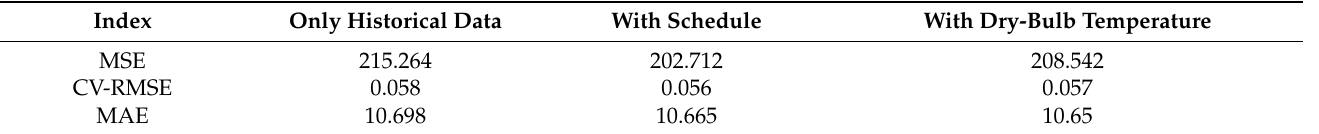
Figure 13. Hourly lighting electricity forecast in 2017. Table 5. Different model prediction indicators result for lighting electricity consumption.